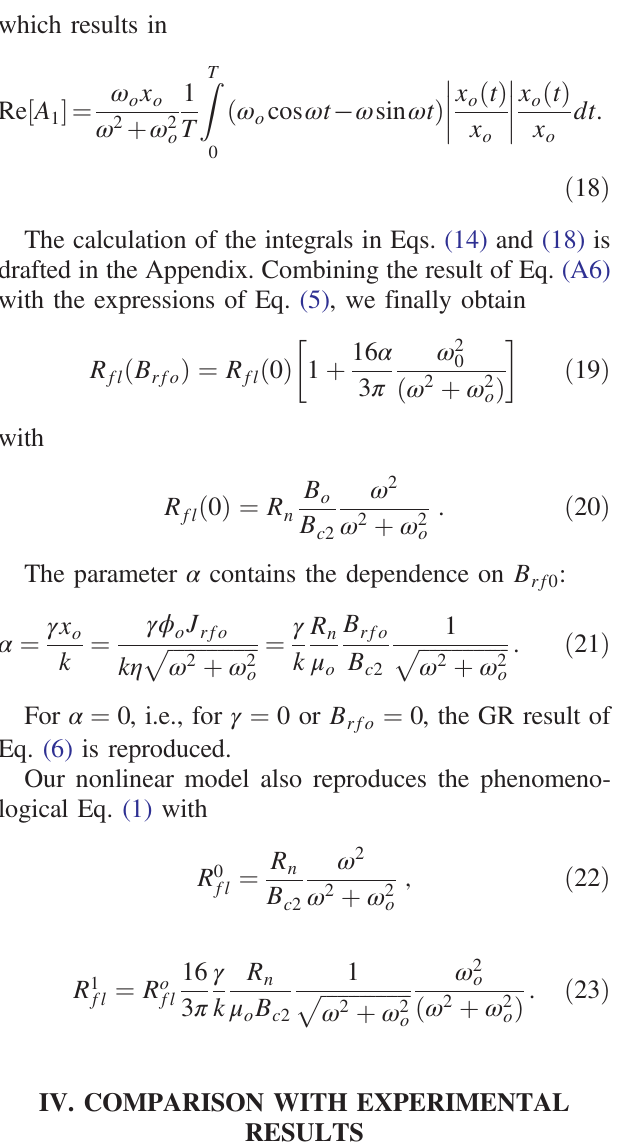
ð 1 . 7 K Þ =B of R for Nb = Cu rf fl ext þ R 1 B . rf fl fl